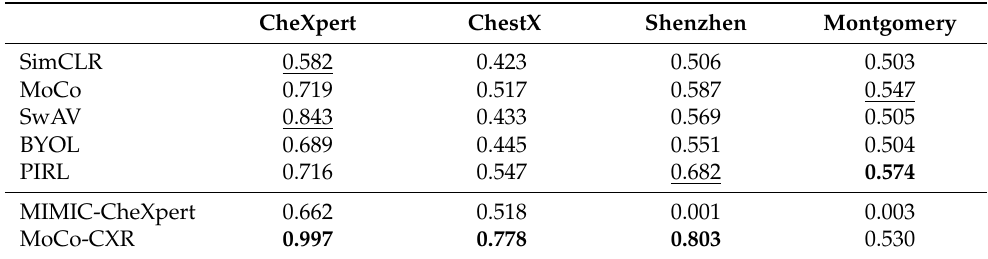
Table A2. Horizontal flip invariance evaluated on the chest X-ray datasets, as measured by cosine similarity. Key: best , second